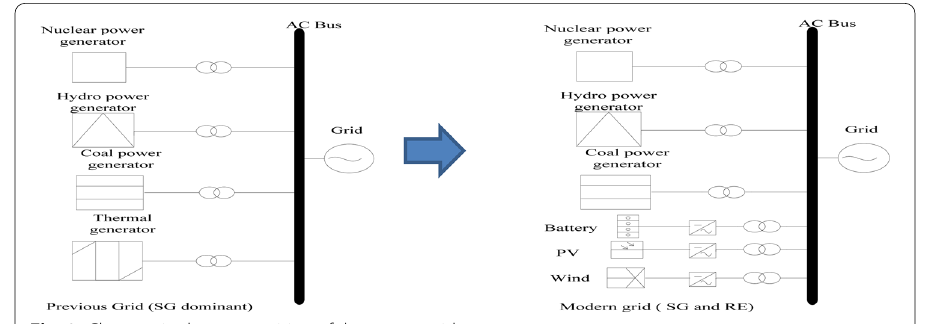
Fig. 2 Changes in the composition of the power